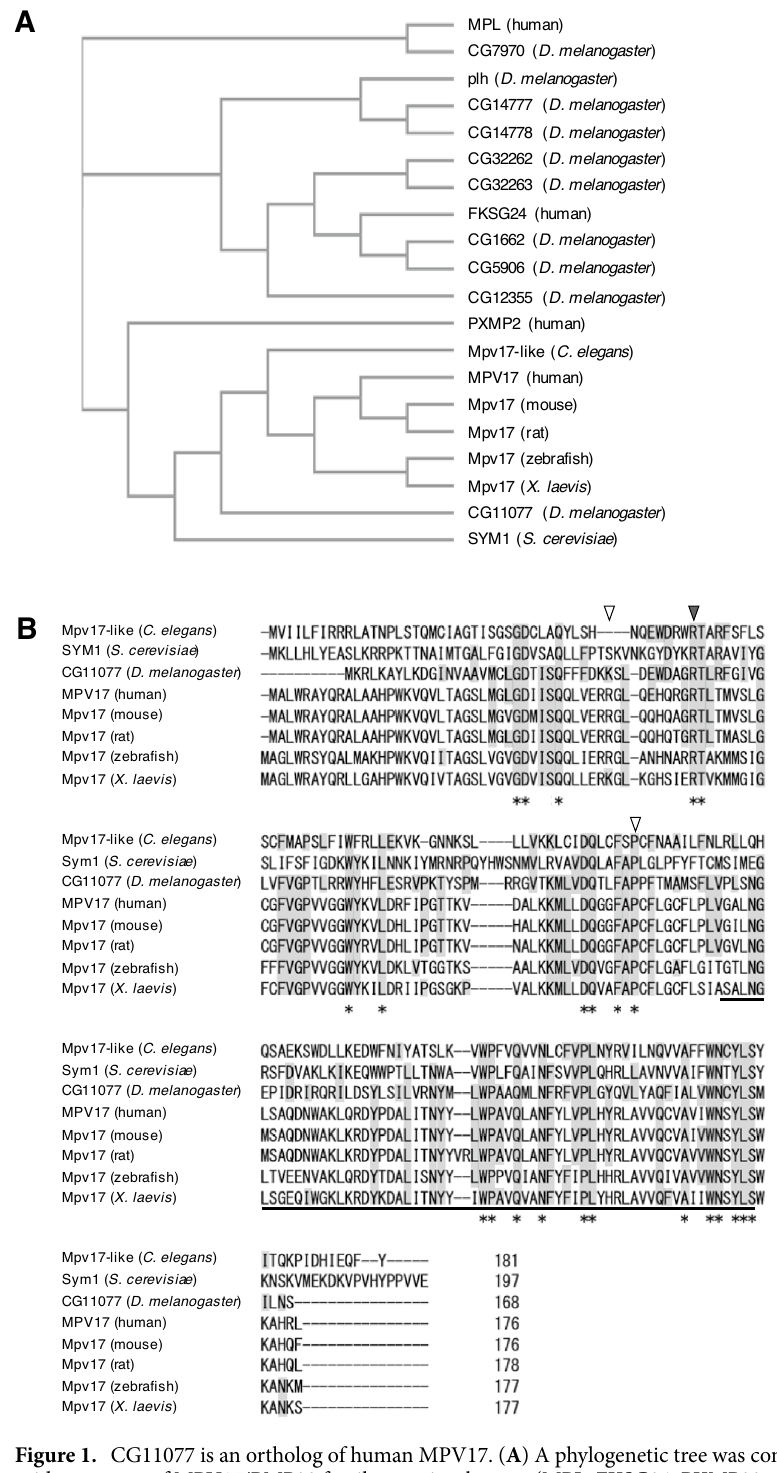
Figure 1. CG11077 is an ortholog of human MPV17. ( A ) A phylogenetic tree was constructed with amino acid sequences of MPV17/PMP22 family proteins, human (MPL, FKSG24, PXMP22, and MPV17), S. cerevisiae SYM1, D. melanogaster (CG7970, CG14777, CG144778, CG32262, CG32263, CG1662, CG12355, and CG11077), C. elegans Mpv17-like, and Mpv17s (mouse, rat, zebrafish, and X. laevis ). The sequence similarity of MPV17/PMP22 family proteins among model organisms and the human MPV17 family was analyzed. ( B ) Multiple alignment of amino acid sequences of Mpv17 among model organisms and human, including CG11077, was carried out with the Clustal Omega multiple sequence alignment program. Amino acids conserved among all organisms are marked by asterisks and those conserved between D. melanogaster and others are highlighted in gray. The black and white arrowheads indicate the amino acids mutated in MPV17 - related hepatocerebral MDDS (R50Q) and CMT (R41Q and P98L) patients, respectively. Underlining indicates the amino acid sequences conserved between PMP22 and MPV17 (Mpv17/PMP22: